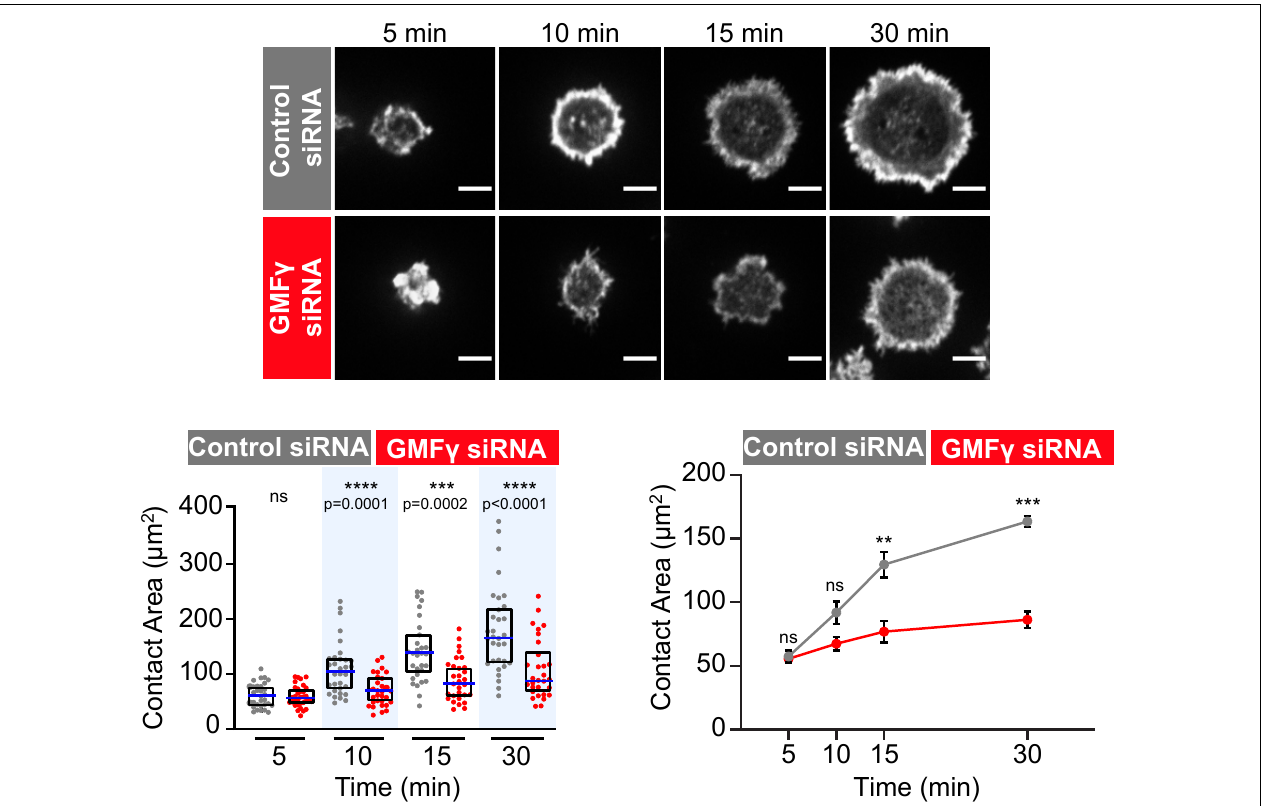
FIGURE 2 | Depleting GMF γ reduces B cell spreading on immobilized HEL. Raji D1.3 B cells that had been transfected with either control siRNA or GMF γ siRNA were added to coverslips coated with 0.22 µ g/cm 2 HEL and allowed to spread for the indicated times. Representative confocal microscopy images of cells stained with rhodamine-phalloidin are shown. Scale bars: 5 µ m. The cell area was quantified using the actin staining to define the cell edge. In the dot plot (left graph), each dot represents one cell, the median (blue line) and interquartile ranges (black box) for > 30 cells are shown for each time point, and p -values were determined using the Mann-Whitney U -test. The line graph on the right shows the mean ± SEM of the median cell areas from three independent experiments. Where no error bars are shown, they were smaller than the symbols. p -values were determined using paired two-tailed t -tests. **** p < 0.0001; *** p < 0.001; ** p < 0.01; ns, not significant ( p >